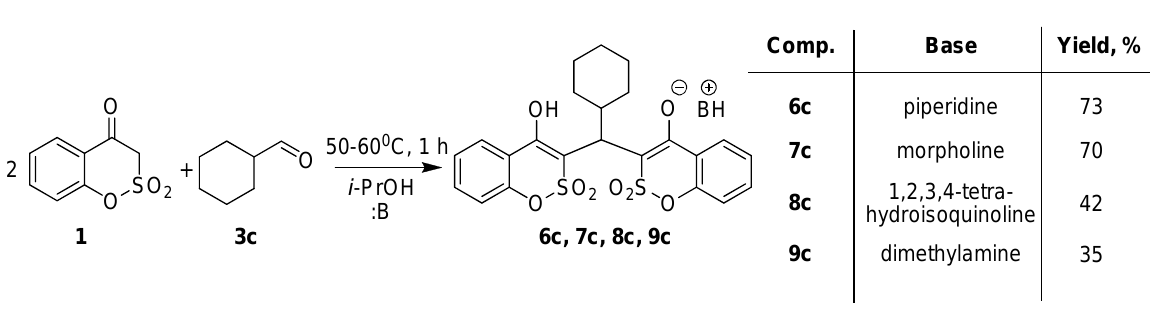
Fig. 5. Synthesis of the ammonium salts 6c, 7c, 8c,